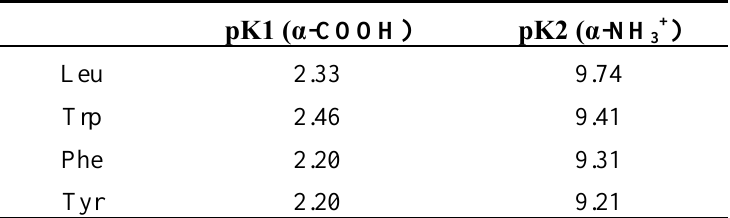
Table 10. pK1 and pK2 of Leu, Trp, Phe and Ty